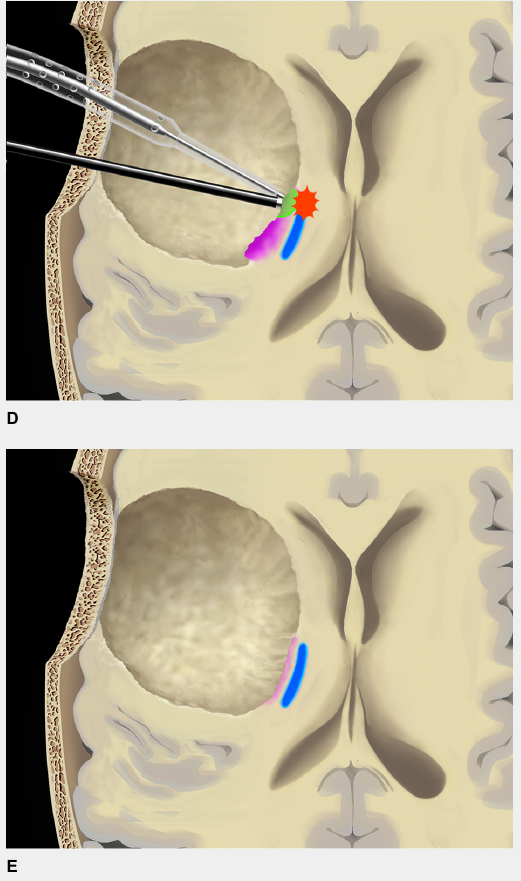
Use of the continuous dynamic mapping device. The continuous dynamic mapping device is used once the surgeon approaches the CST (A) . Resection is continued with an initial stimulation intensity of 10–15 mA (corresponding to a distance of 10–15 mm from the CST). The instant an MEP is elicited (B) , the surgeon is alerted by the change of the high-pitch negative control sound to a low-pitch alert sound. The stimulation intensity is then reduced by 2 mA, and the resection is continued at sites negative for the set current (C) , until again the acoustic switch from the negative control to the alert sound warns the surgeon that the MT has been reached (D) . This stepwise approach is continued until a minimal threshold is reached (E) . Pink indicates tumor tissue, blue indicates CST fibres, green indicates a region of active resection, and red indicates that an alert sound has occurred. Copyright Andreas Raabe. Published with